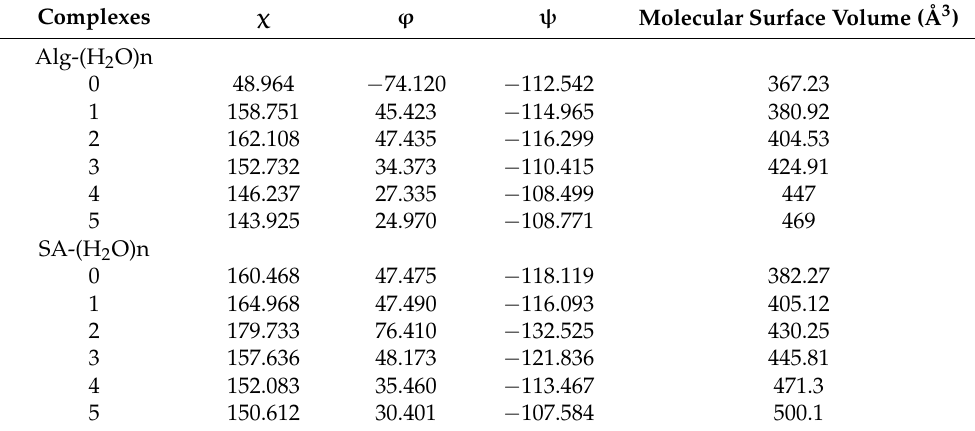
Table 1. Conformation and molecular volume value of